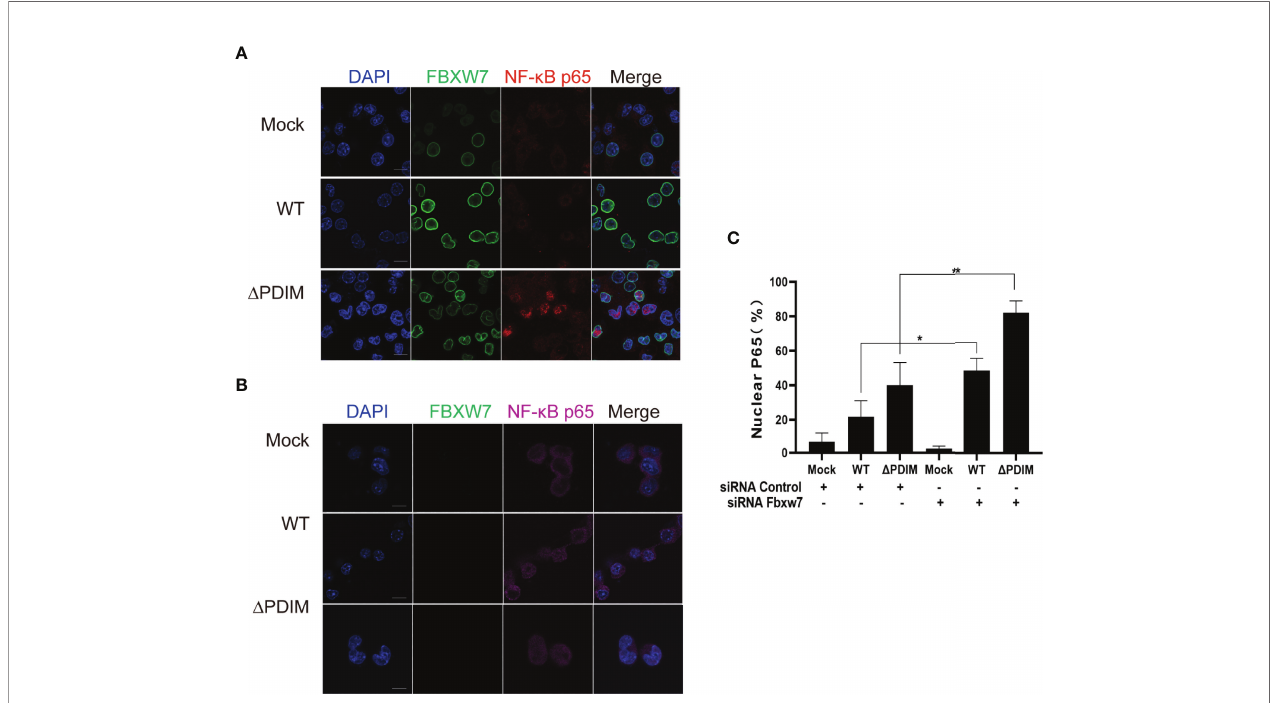
FIGURE 4 | FBXW7 in fl uences the expression and location of NF- k Bp65 in Mm -infected macrophages. (A, B) Representative immuno fl uorescence images of macrophages stained for the FBXW7 (green, FITC-labeled second antibody) and the NF- k Bp65 (red or purple, Alexa Fluor 647- or Alexa Fluor Plus 405- labeled the second antibody). Nuclei were counterstained with DAPI to identify the cellular location of FBXW7 and NF- k Bp65. Scale bar, 10 m m. (C) the percentage of nuclear NF- k Bp65 positive cells in the immunohistochemical images in (A, B) . The averaged values represent the mean ± standard deviation (SD) (n = 3 per group). At least 200 total nuclei per well were counted, and the signal for nuclear p65 was quanti fi ed as the percentage of nuclei number (DAPI) merged with p65 divided by the total number of nuclei counted per well, n = 3 wells per condition. * P < 0.05 and ** P <